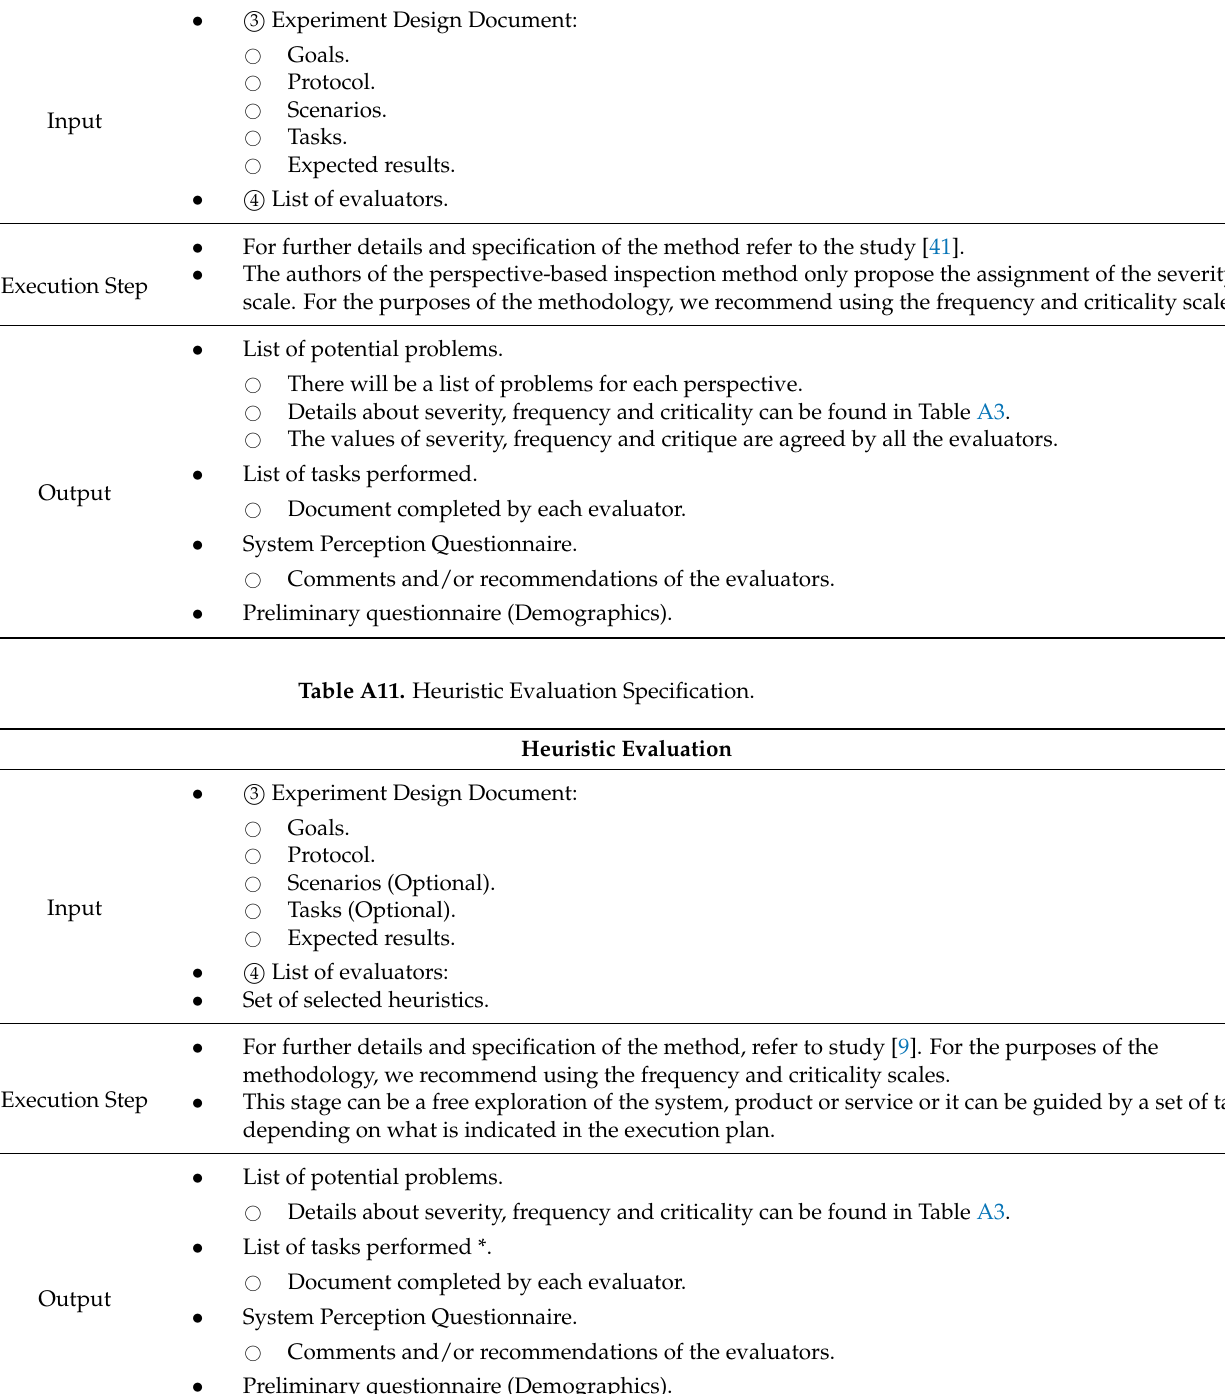
Table A10. Perspective-Based Inspection Specification. Perspective-Based Inspection